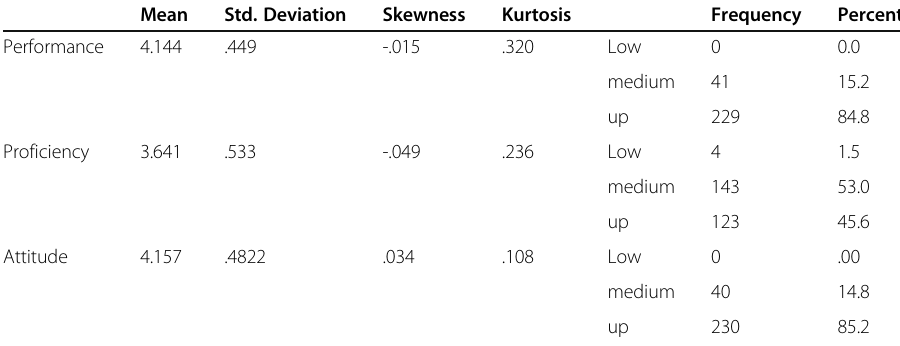
Table 2 Frequency distribution and descriptive indexes of responses related to the variable of performance, proficiency, and attitude Mean Std. Deviation